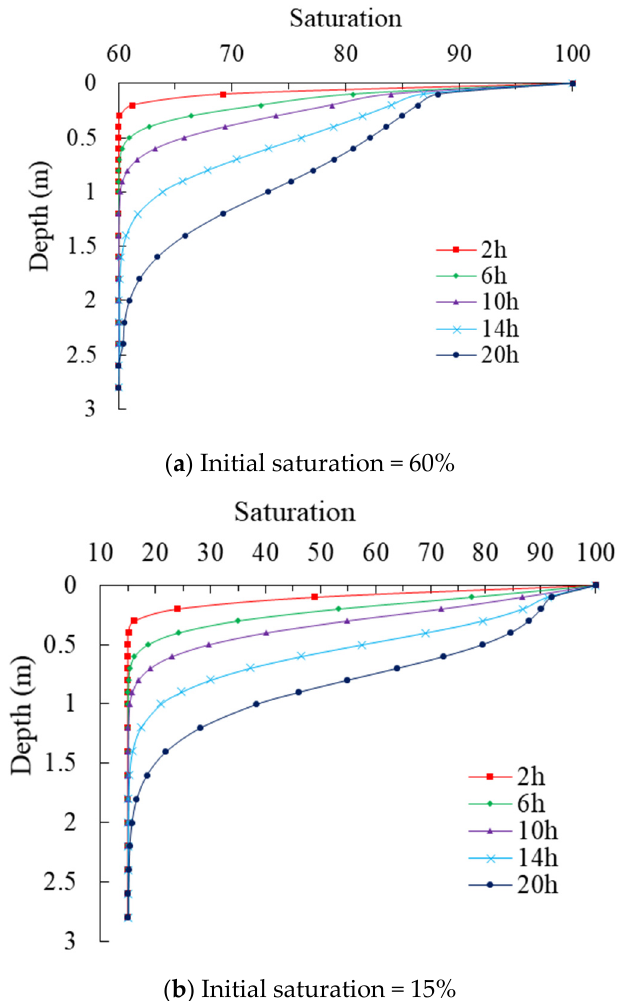
Figure 12. Saturation distribution in depth over time at various initial saturation degrees.